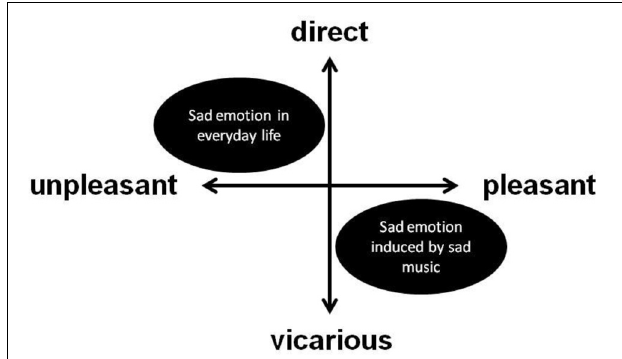
FIGURE 3 | Pleasant-unpleasant, direct-vicarious